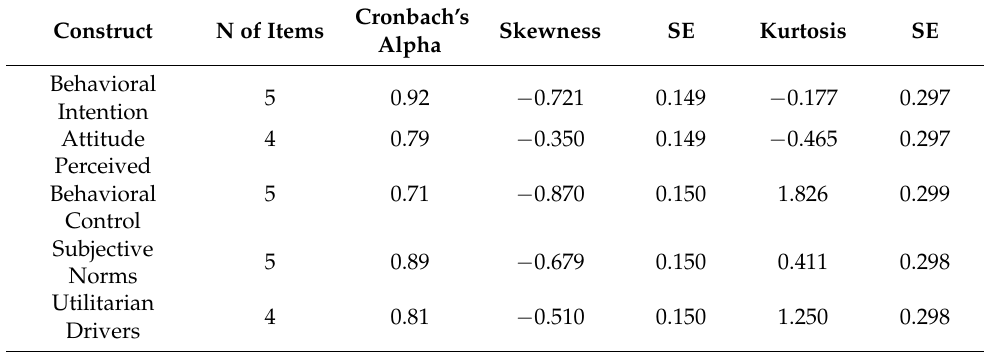
Table 6. Cronbach’s alpha, Skewness and Kurtosis of the TPB constructs.